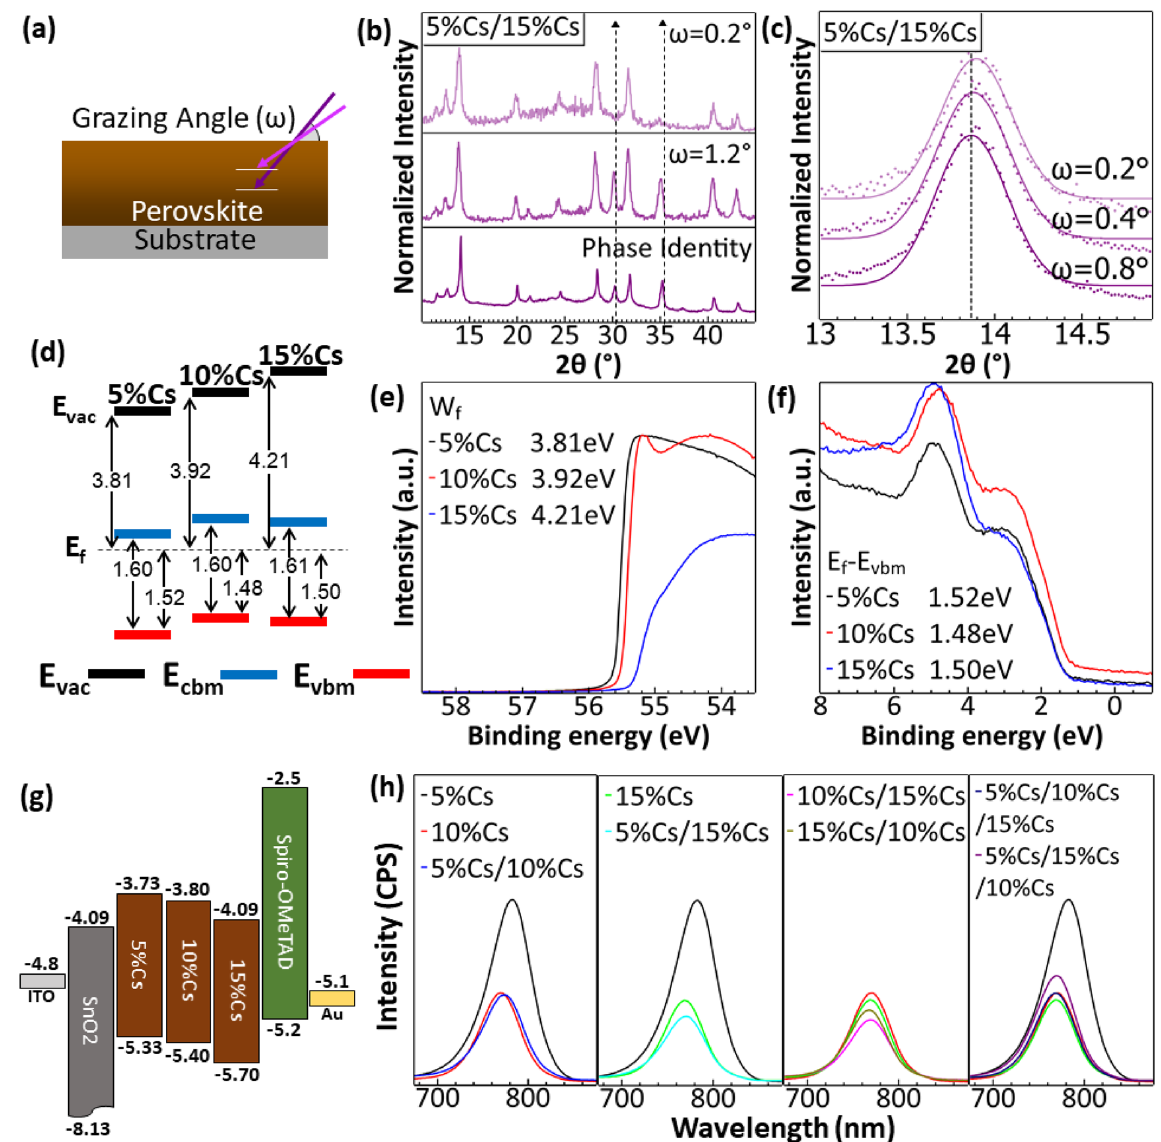
Figure 2. ( a ) Grazing incident X-ray diffraction (GIXRD) scanned at a deeper level with a larger grazing angle (ω) ( b ) GIXRD spectra of 5%Cs/15%Cs with different grazing angles. Phase identity is equivalent to that from the normal XRD. ( c ) GIXRD spectra of 5%Cs/15%Cs at the 2θ from 13° to 15° with guassian fits to identify X-ray diffraction peaks. ( d ) Band diagrams of 5%Cs, 10%Cs, and 15%Cs perovskites aligned by having E f equals to zero, representing band alignment when perovskite films come in contact with each other. ( e ) Ultraviolet photoelectron spectroscopy (UPS) spectra at the secondary electron cutoff region and ( f ) at the valence band region of 5%Cs, 10%Cs, and 15%Cs. ( g ) Band diagrams of 5%Cs, 10%Cs, and 15%Cs aligned by having E vac equals to zero 45,49 . ( h ) Photoluminescence (PL) spectra of single, double, and triple-layer perovskite films showing quenching of multi-layer perovskite films compared to that of single-layer perovskite significant increase in thickness of the triple-layer perovskite film was the result of less “lower layer dissolution” and slightly naturally thicker 15%Cs perovskite film as shown in Fig. S5. The thicker double and triple-layer perovskite films confirmed the idea of using SSD as an effective deposition method to fabricate double and triple-layer perovskite films with an acceptable interface between perovskite layers. Grazing incident X-ray diffraction spectroscopy (GIXRD) can be used to observe material compositions at different depths. In Fig. 2a, the depth of the observed materials is dependent on a grazing angle. The GIXRD spectra in Fig. 2b show that at the 0.2° grazing angle no peak from ITO substrate was observed; at the low angle, the X-ray only scanned the top surface of the perovskite film. However, at the grazing angle of 1.2°, we observed X-ray diffraction peaks from the ITO substrate at 2θ around 30.5° and 35.5°, indicating deeper scanning depth. In Fig. 2c, the gaussian fits of the GIXRD spectra were used to determine the peak positions of a double-layer 5%Cs/15%Cs perovskite film with grazing angles of 0.2°, 0.4°, and 0.8°. The positions of 2θ of the perovskite peak